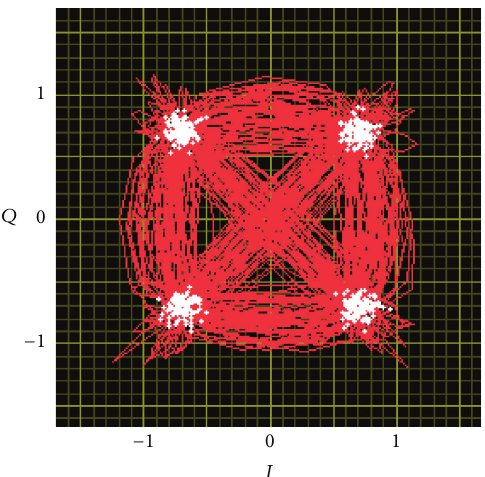
Figure 12: Constellations of the demodulated signal.